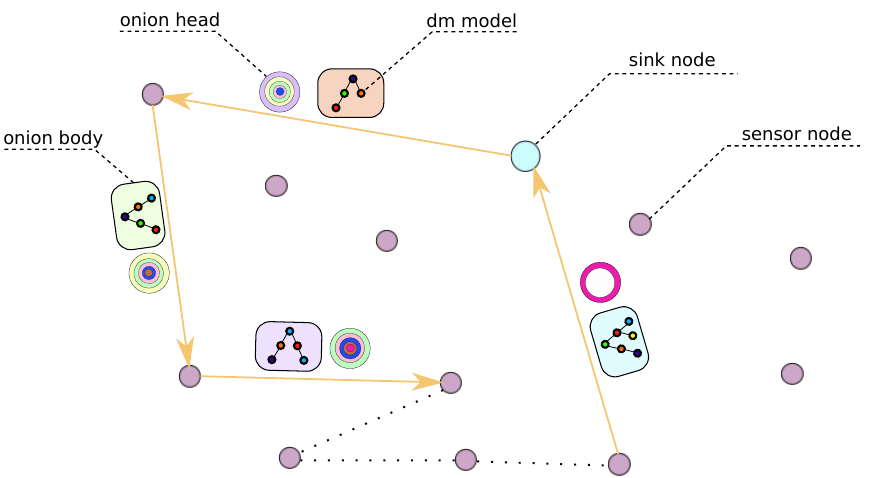
Figure 3. The figure shows the onion message traveling through the network and updating the DM model at sensor nodes in the message path. The onion head and onion body color change at each message processing to indicate the encryption